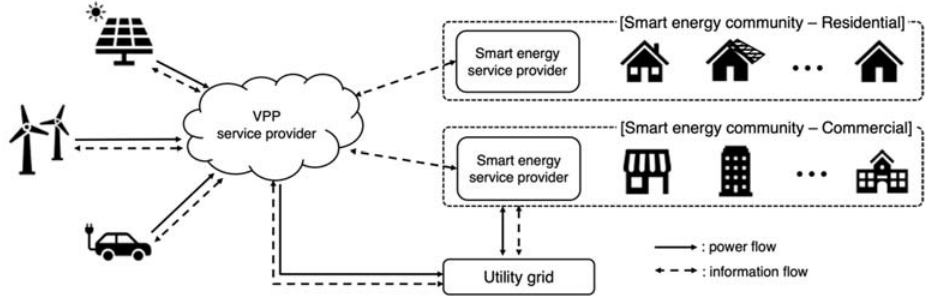
Figure 1. Constitution of a virtual power plant for smart energy communities.